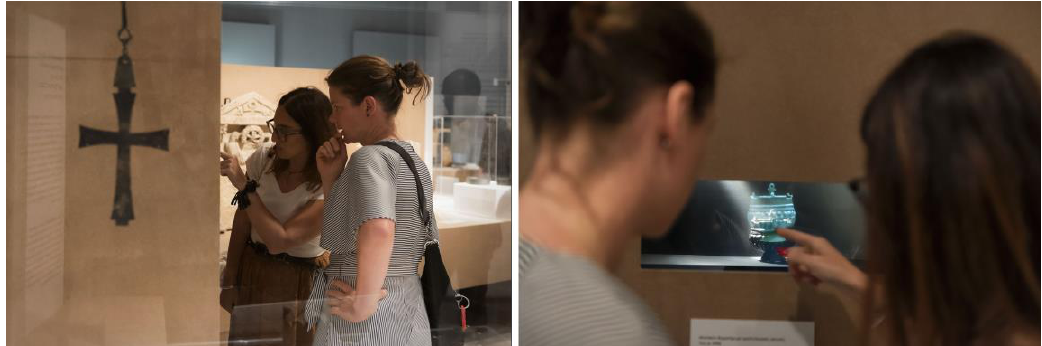
Figure 4. Small holographic showcase where the hologram interacts with the real object inside, Byzantine and Christian Museum in Athens, 2018. Realized by Moobels and APM within the EU CEMEC project